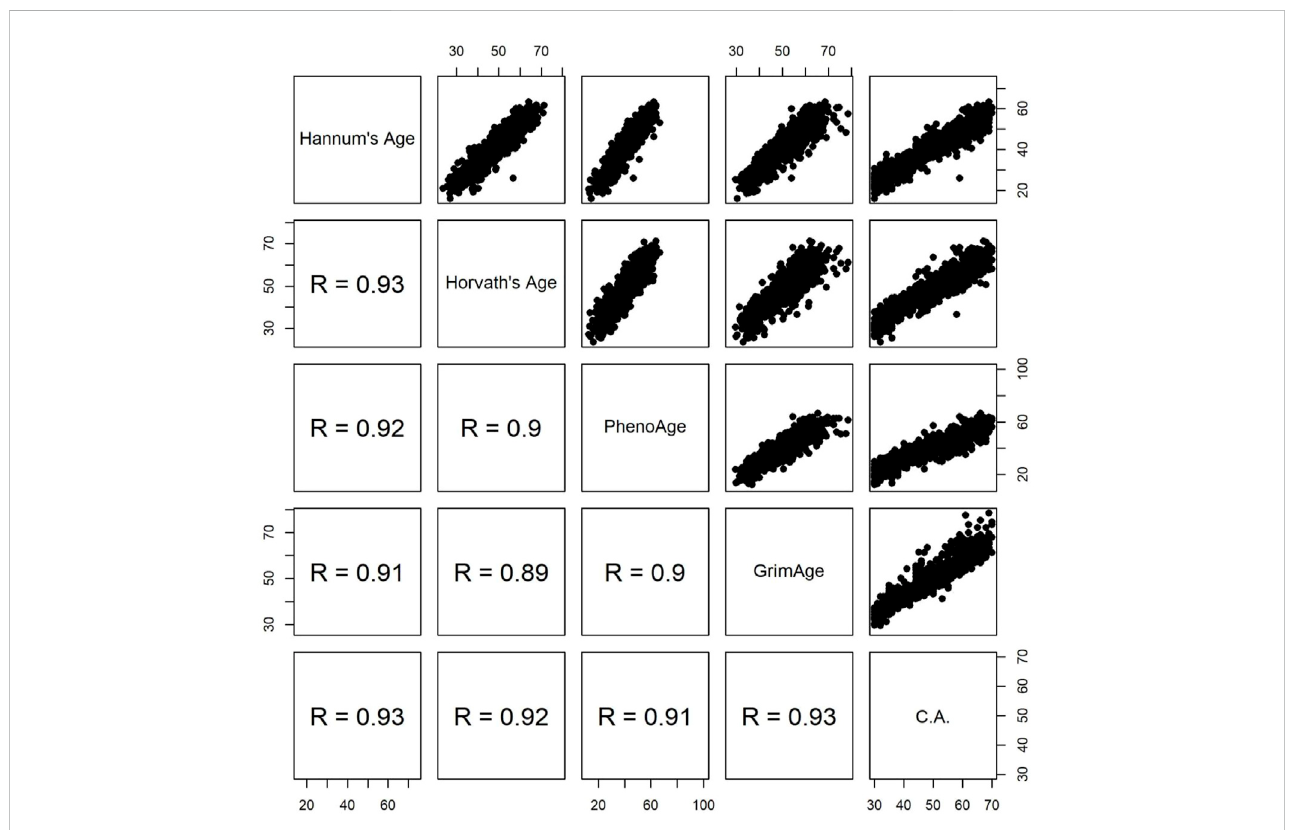
FIGURE 1 Pairwise scatter plots of four measures of DNAm age and chronological age (C.A). R represents Spearman ’ s rank correlation coef fi